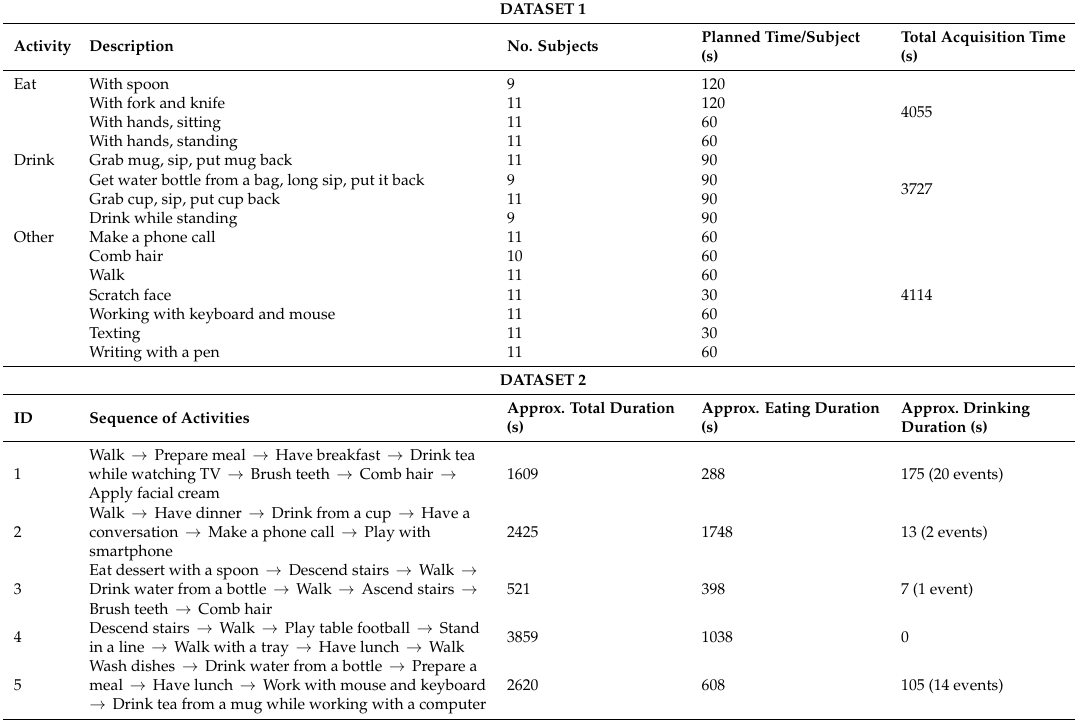
Table 3. Description of the